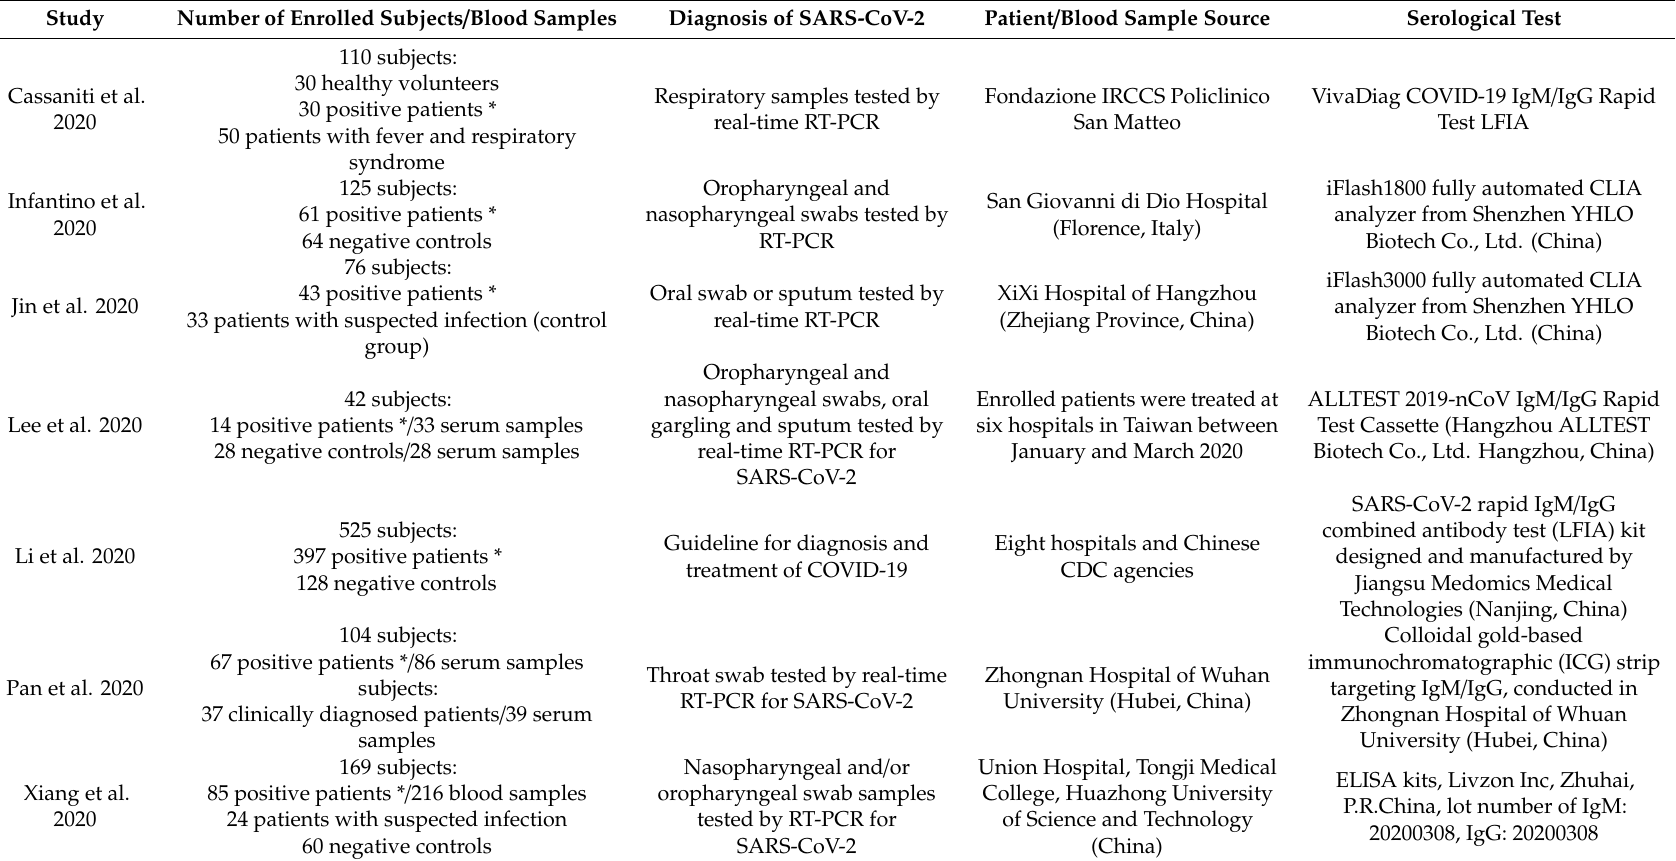
Table 2. List of the included